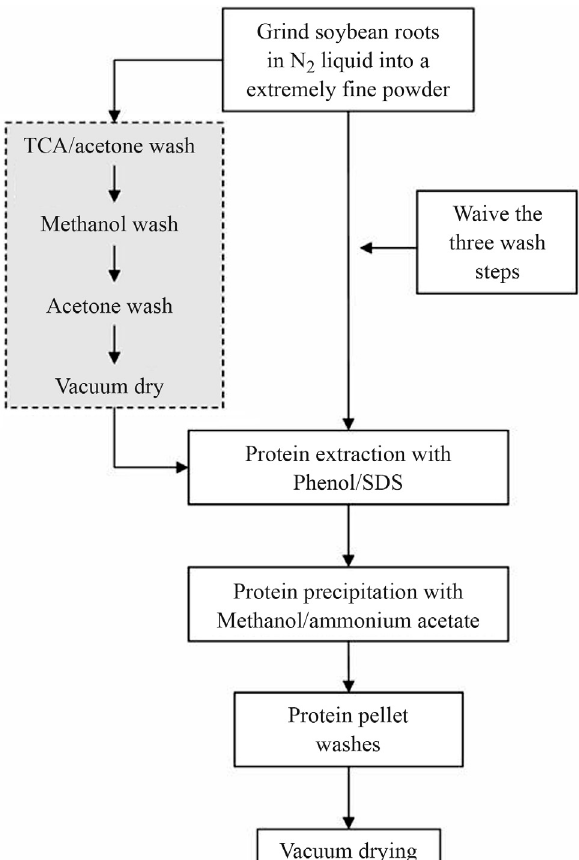
Figure1 -Schematicoutlineoftheprotocolpresentedhere.Themodifica- tions performed on the original phenol/SDS method (Wang et al. , 2006) are shown in the dashed frames with a gray